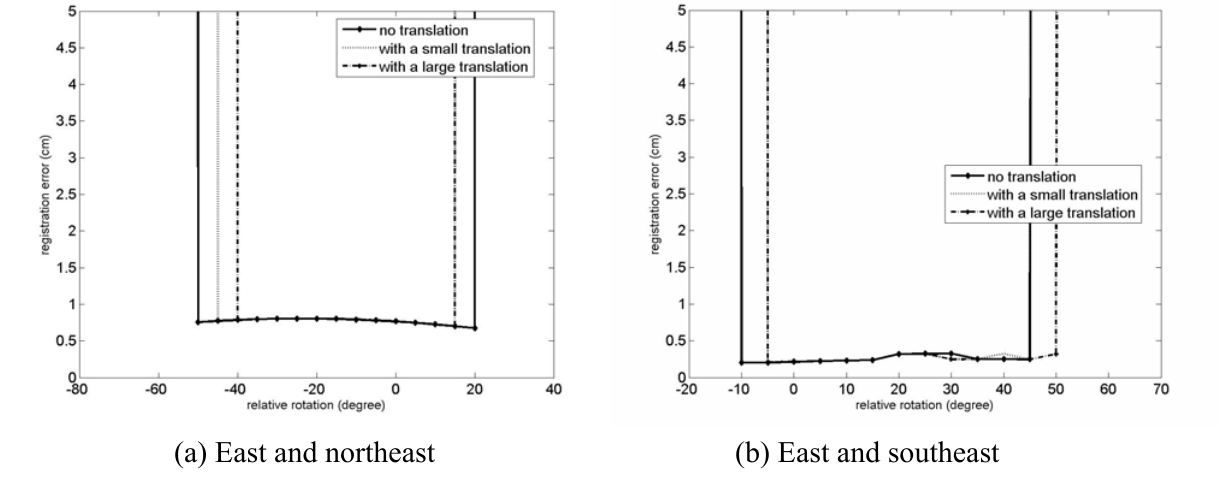
ps D , for the convergence region test of the GP-ICP with Figure 13. Registration errors, std the Agia Sanmarina church data. Large and small translations are [dx, dy, dz] = [0.5 m, 0.5 m, 1.0 m] and [0.1 m, 0.1 m, 0.1 m], respectively. The northeast of the Agia Sanmarina church was rotated around the y axis which is about the surface normal of the ground.